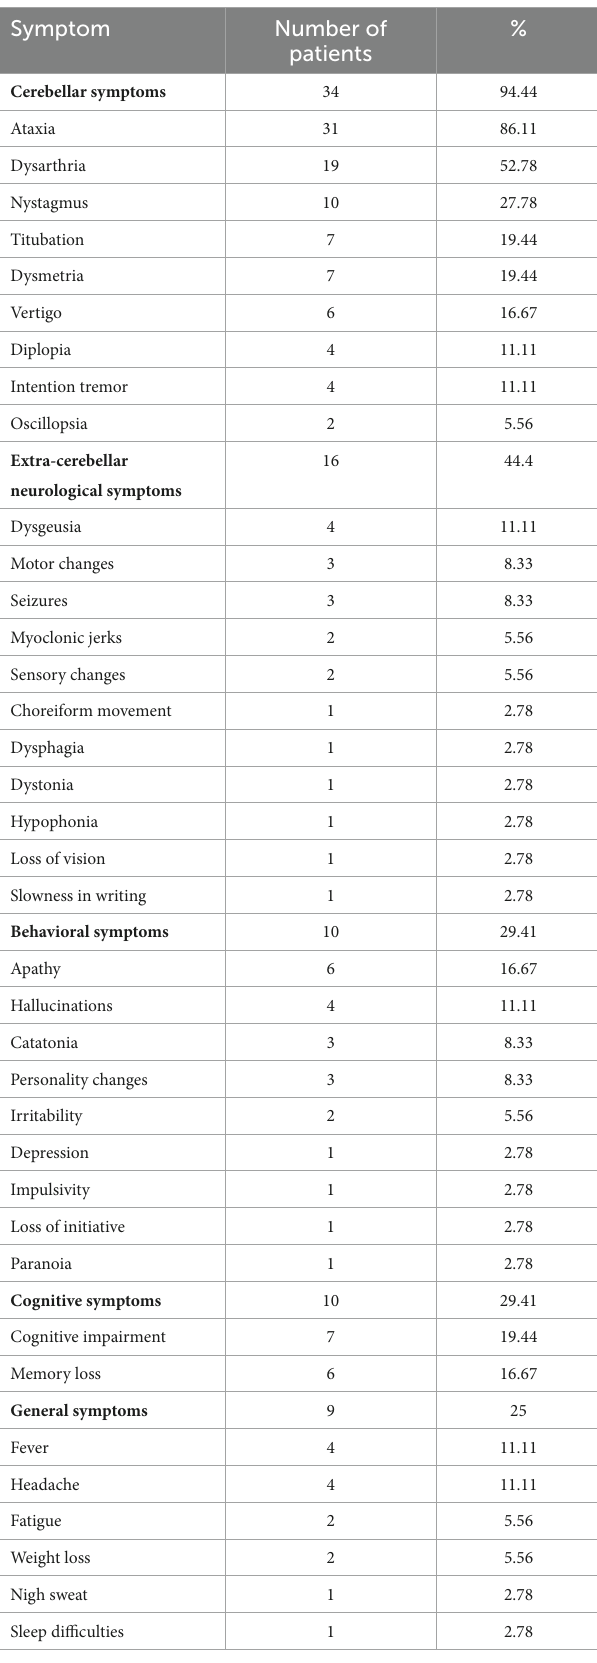
TABLE 2 Summary of anti-mGluR1 encephalitis symptoms and their